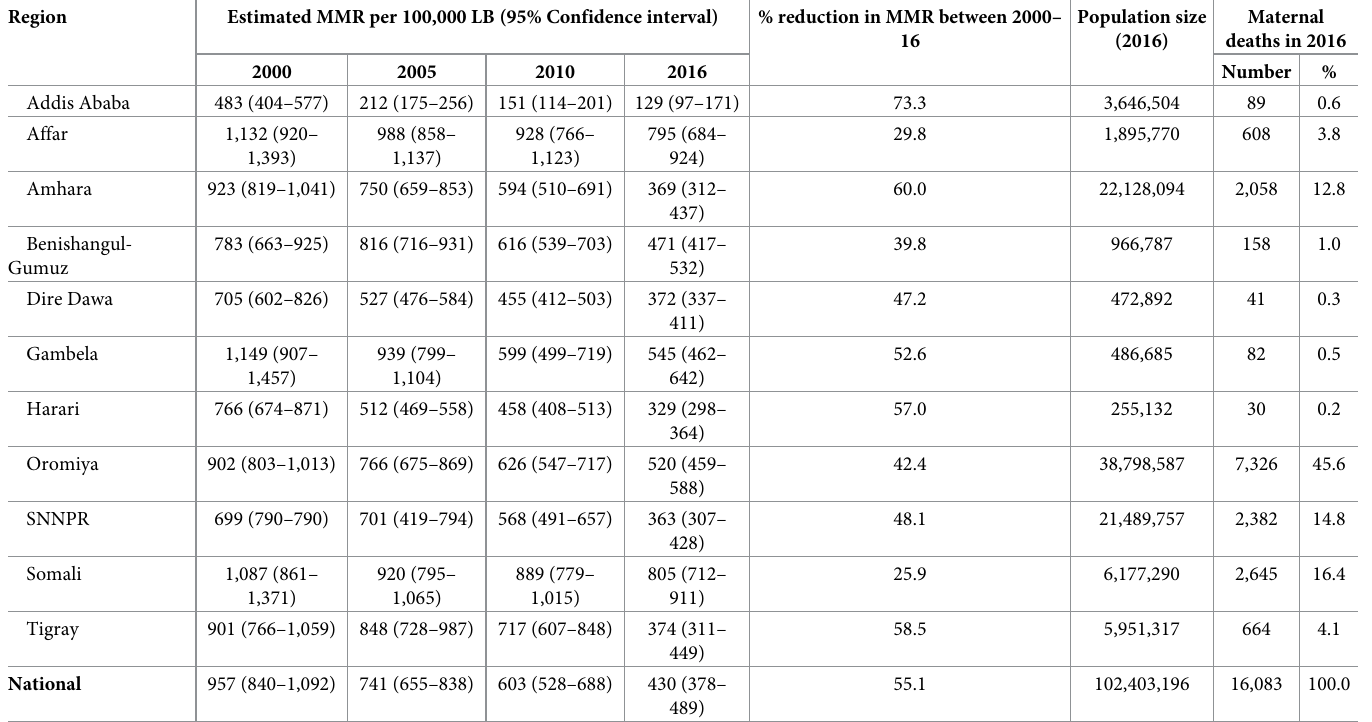
Table 4. Estimated MMR and number of maternal deaths in 11 regions of Ethiopia.